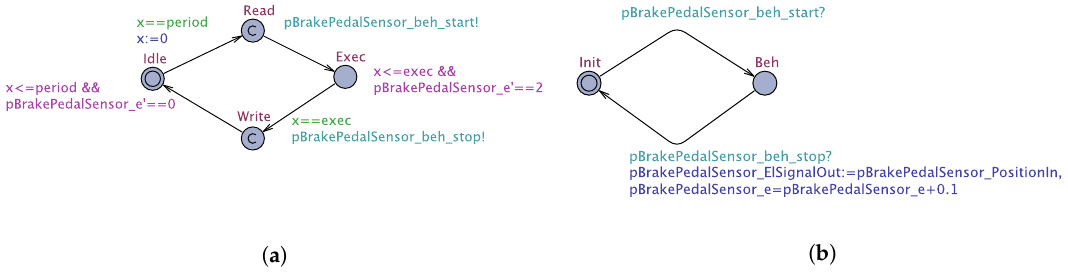
Figure 6. The network of Priced Timed Automata (PTA) for the brake pedal sensor component FunctionPrototype showing the transformed EAST-ADL architectural interface and behavior. ( a ) The interface timed automaton for the brake pedal sensor component. ( b ) The behavior timed automaton for the brake pedal sensor